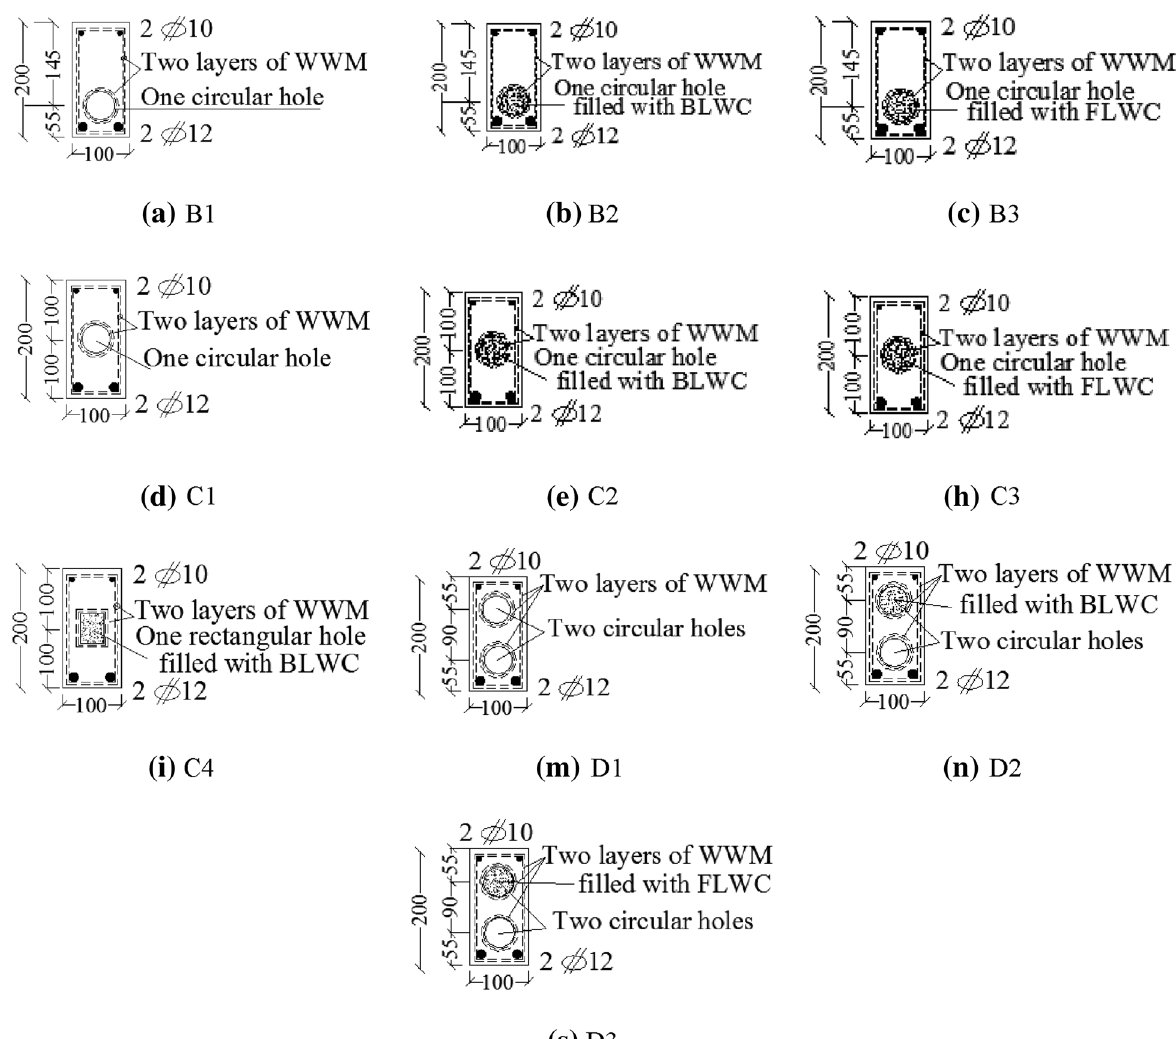
Fig. 10 Cross sections of FC beams, dim in